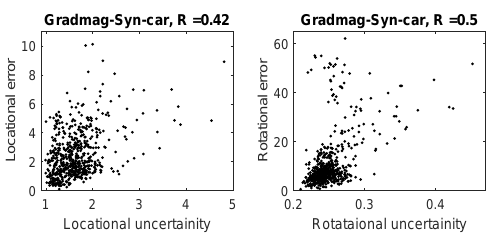
Table 3. Errors and uncertainties corresponding to Figure 10 (c)